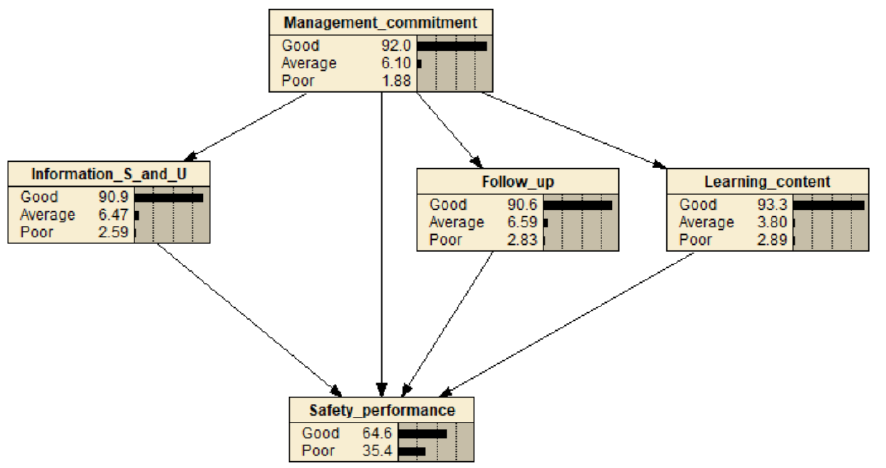
Figure 3. The developed BN model.